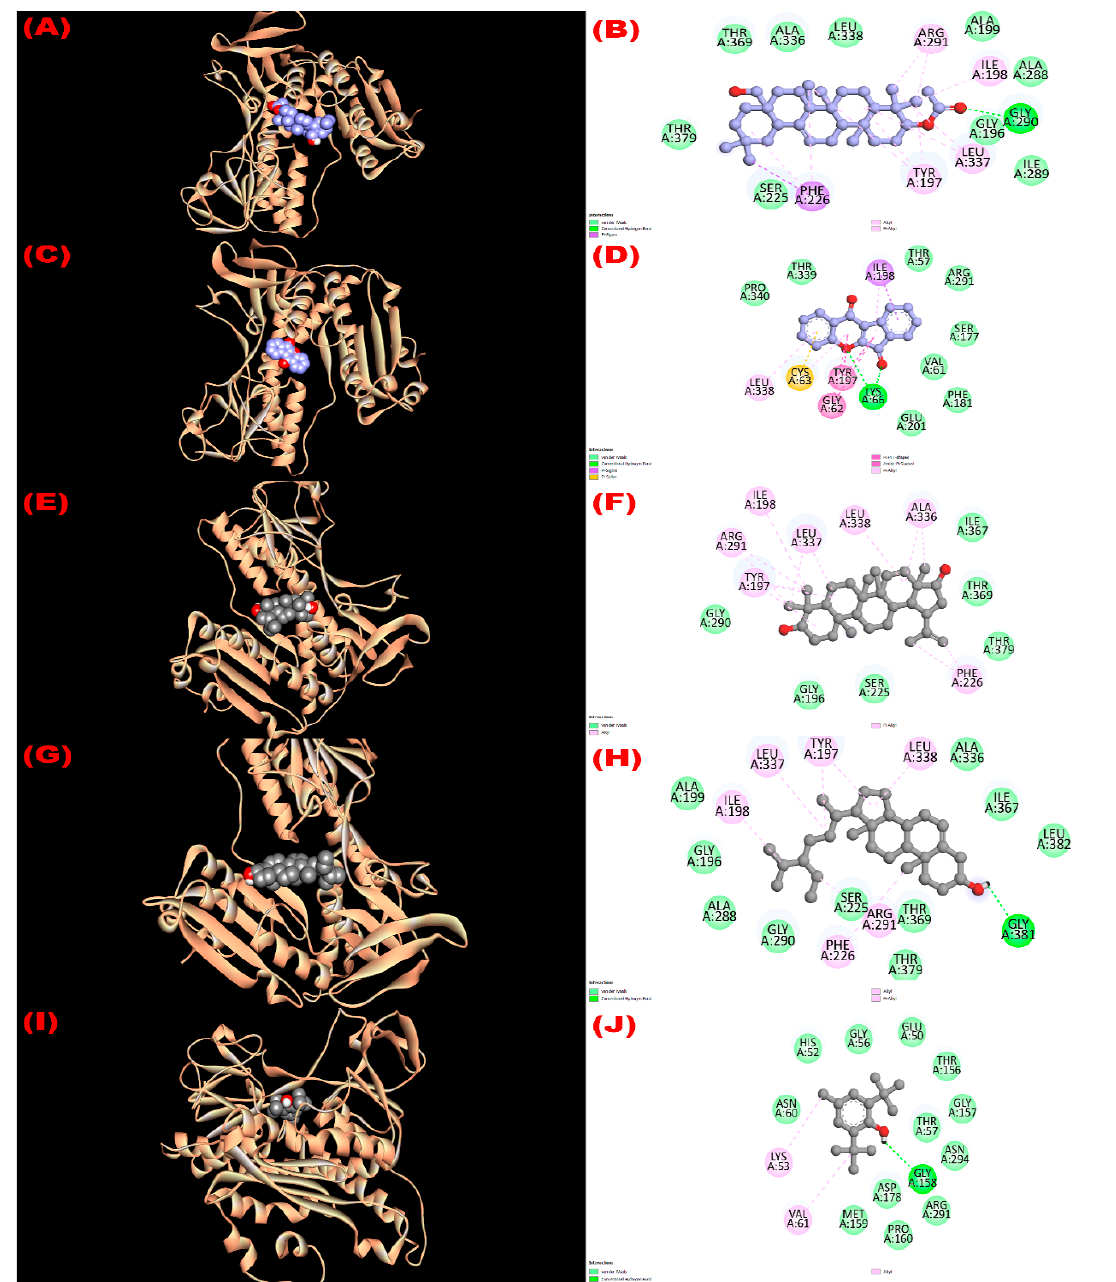
Figure 2. The 3D and 2D molecular interactions of the isolated compounds with the glutathione reductase enzyme (PDB ID: 3GRS) revealing the antioxidant potentiality. (( A , B ), ( C , D ), ( E , F ), ( G , H ), ( I , J ) sketched the pictorial view of molecular docking of compounds ( 1 to 4 ) 3 β -acetyloxy-olean-12- en-28-ol, Wrightiadione, 22 β -hydroxylupeol, β -sitosterol, and the standard BHT, respectively).